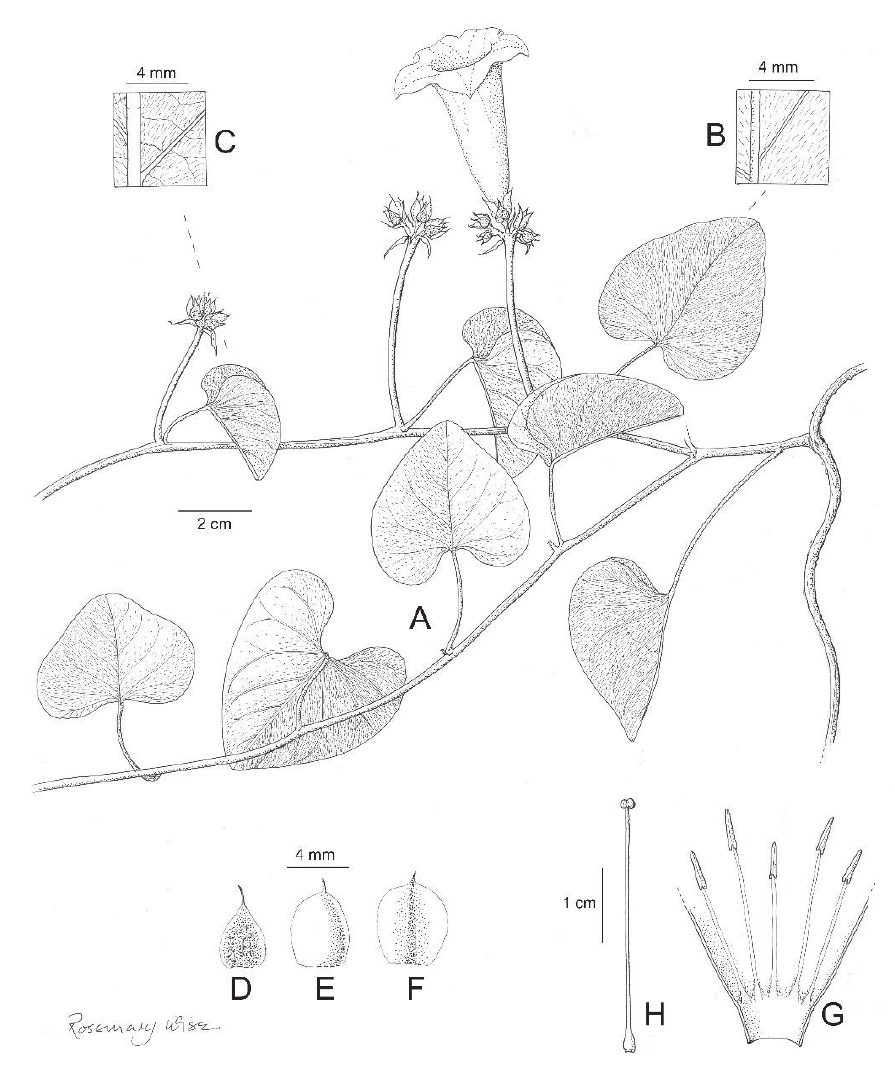
Figure 10. Ipomoea fasciculata. A habit B adaxial leaf surface C abaxial leaf surface D outer sepal e middle sepal F inner sepal G corolla opened out to show stamens h ovary, style and stigma. Drawn by Rosemary Wise from P. Gomes et al.